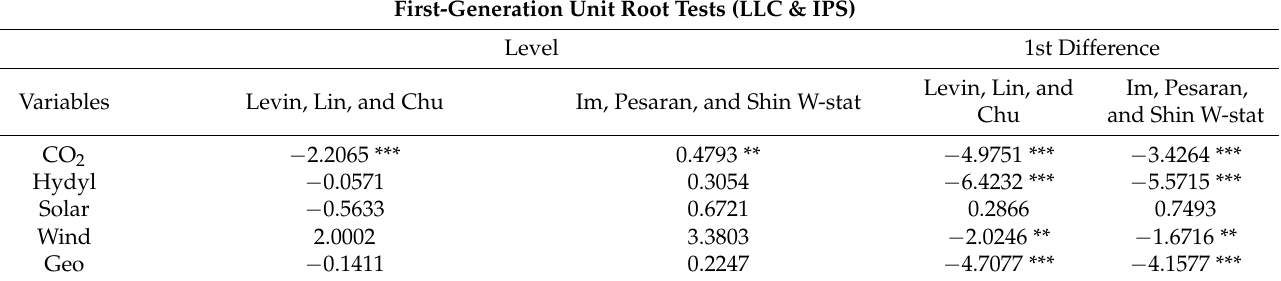
Table 4. Unit Root (First & Second Generation) Tests